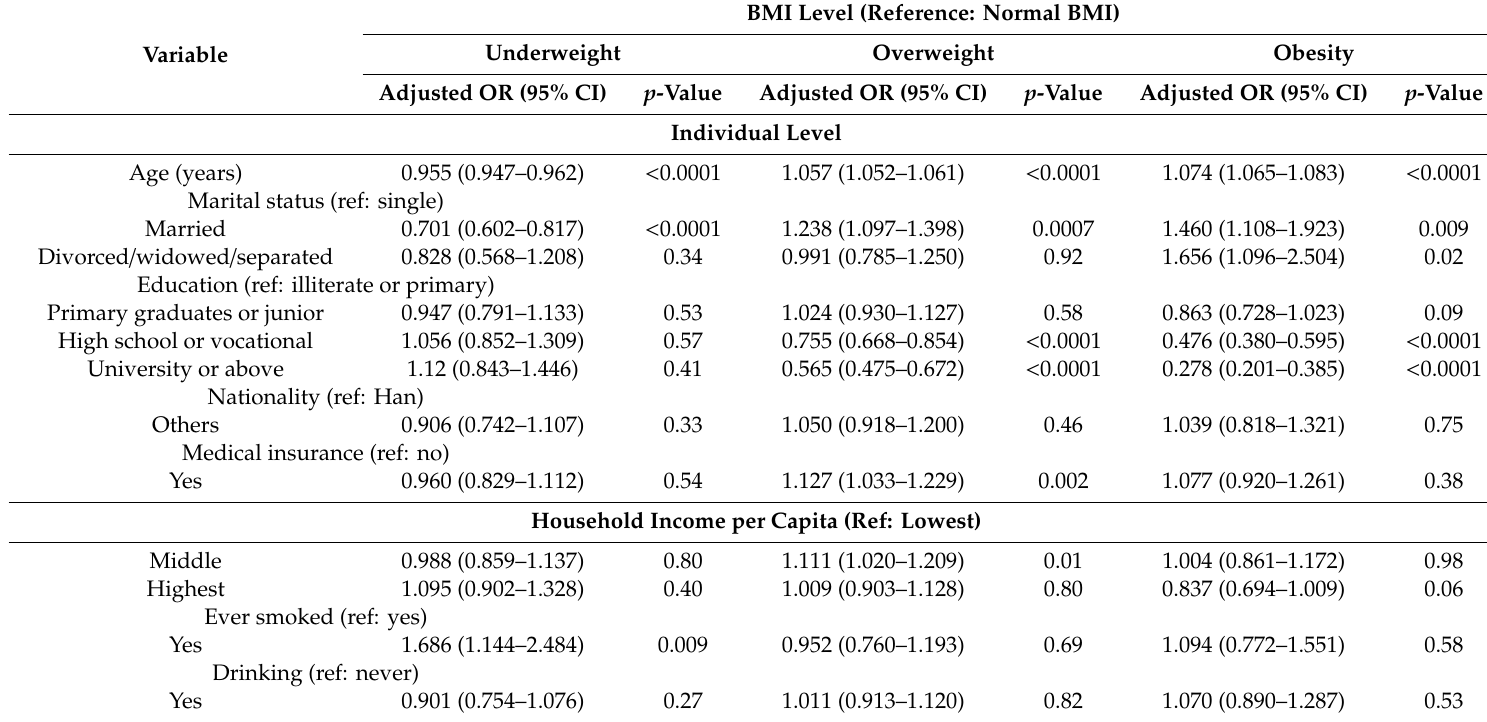
Table 2. Adjusted odds ratio (OR) and 95% confidence interval (CI) for predictors of unordered multinomial logistic models (using normal BMI as the reference) predicting malnutrition for women of reproductive age from the CHNS,